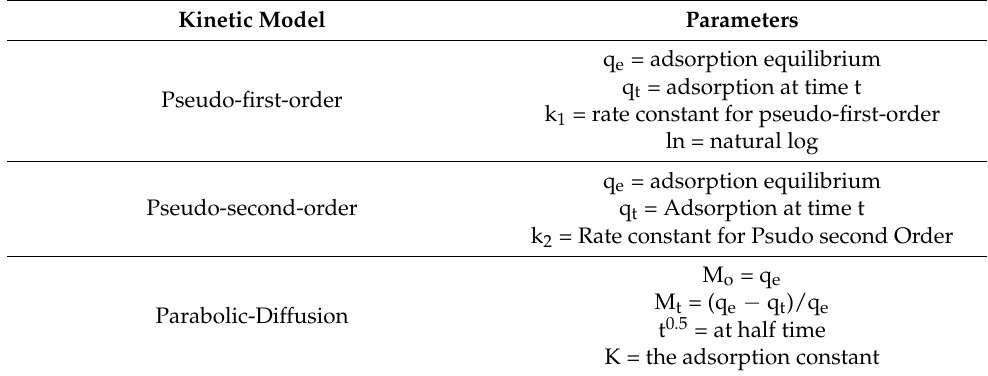
Table 2. Kinetic models and their detailed